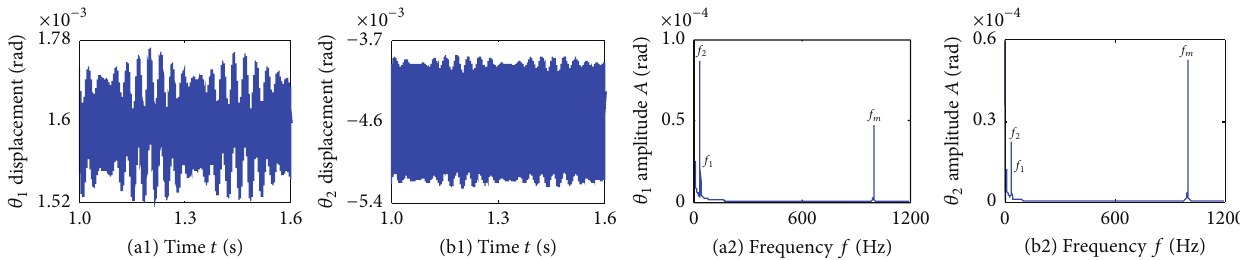
Figure 7: Torsional waveform and frequency spectrum at 𝑛 1 = 700 r/min, 𝜌 1 = 2.0 × 1 0 −6 m, and 𝜌 2 = 2.0 × 1 0 −5 m.